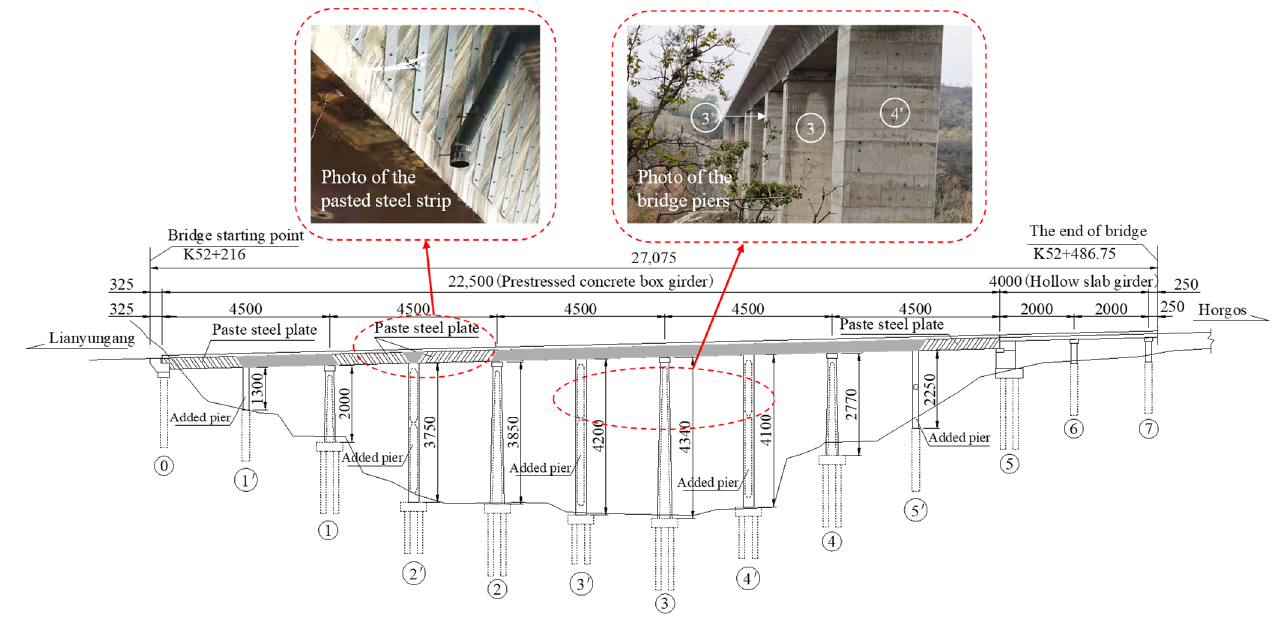
Figure 6. Reinforcement schematic of Scheme 2 (unit: cm).